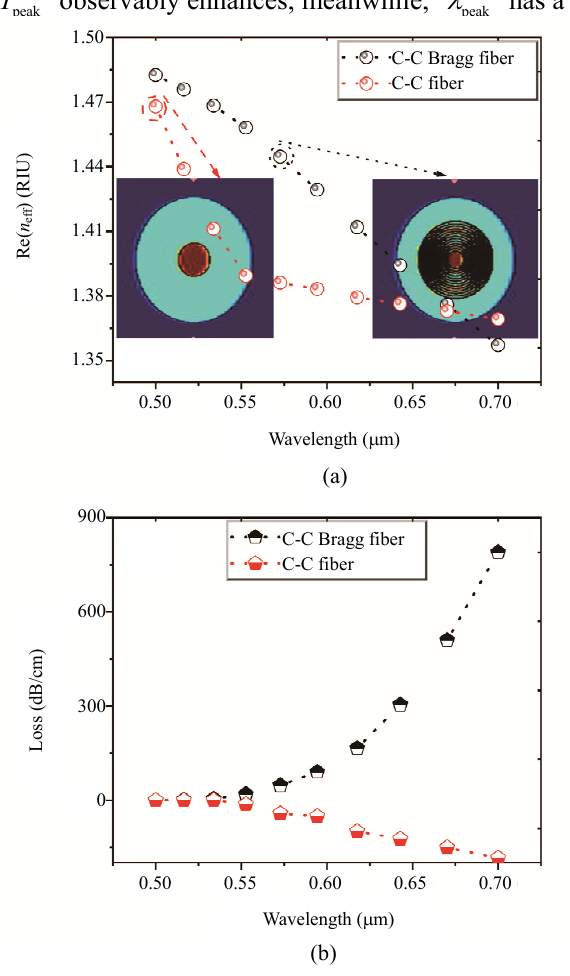
Fig. 2 Model analysis for (a) the real parts of (b) modal loss of fundamental mode with C-C Bragg fiber and C-C fiber as a function of the wavelength, calculated for and 1.5 n  2